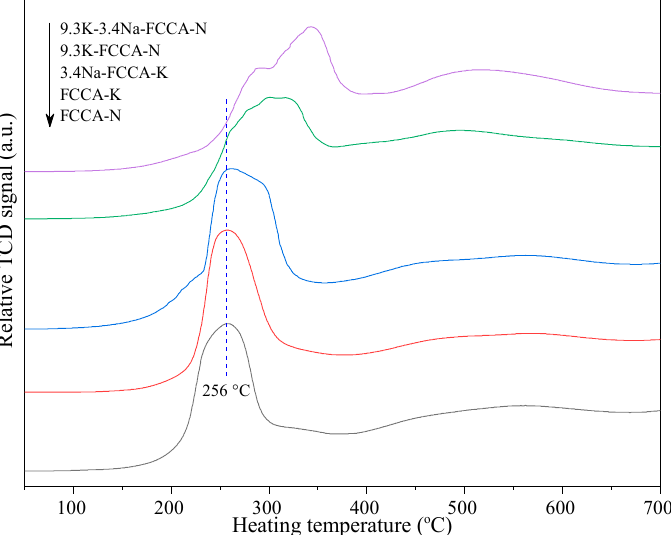
Figure 2. H 2 -TPR profiles of FeCoCuAl catalysts before and after K and/or Na modification.